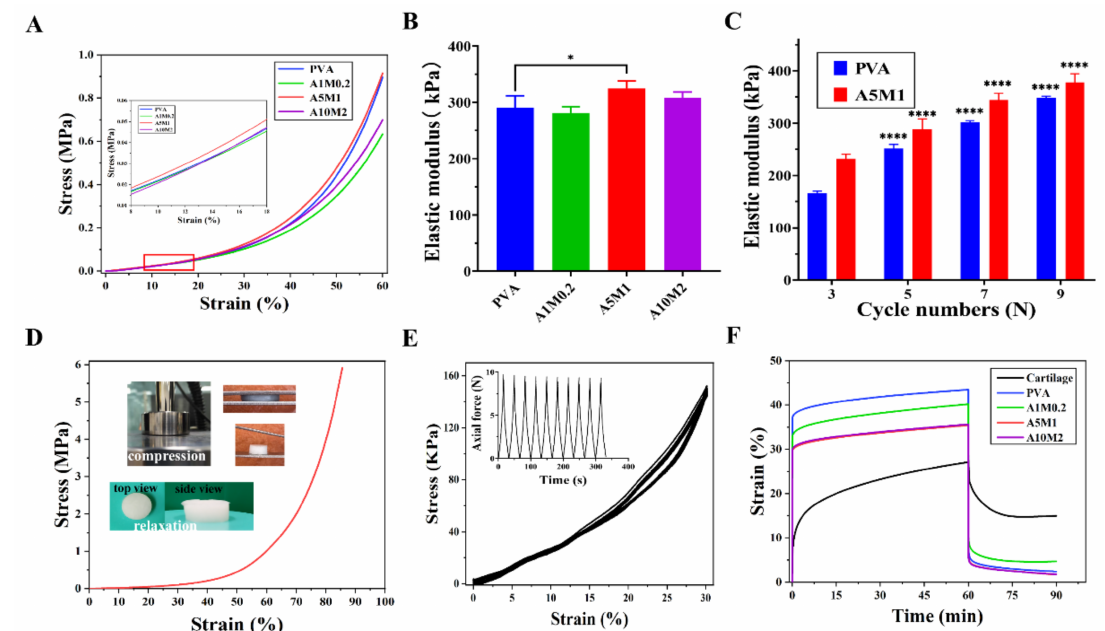
Figure 4. Mechanical properties of the HPX/PVA hydrogels. ( A ) The compressive stress–strain curves of the PVA and HPX/PVA hydrogels.; illustration from the linear regime, with the strain range of 8–18%. ( B ) The compressive moduli of the PVA and HPX/PVA hydrogels. ( C ) The effect of the number of freeze-thaw cycles on the compressive moduli of the PVA and A5M1 hydrogels. ( D ) The compressive stress–strain curve of the A5M1 hydrogel compressed to 85% strain; illustration of compression and relaxation of the A5M1 hydrogel. ( E ) The cyclic compressive stress–strain curves of the A5M1 hydrogel; illustration of time and axial force in the cyclic compressive test. ( F ) The creep curves of the PVA and HPX/PVA hydrogels versus porcine articular cartilage. The error bars indicate the mean ± standard deviations from at least three independent experiments. Statistical analysis was performed using ANOVA with Dunnett’s multiple comparisons (* p < 0.05, **** p <